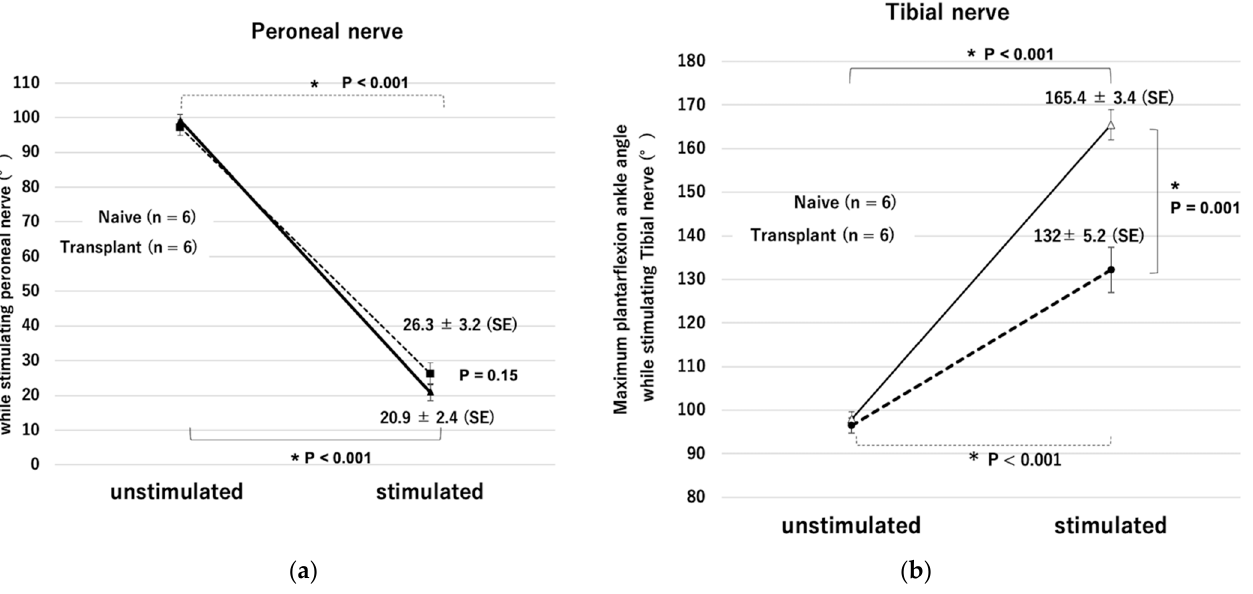
Figure 7. Changes in maximum ankle angle during electrical stimulation. ( a ) Maximum dorsiflexion while stimulating the peroneal nerve. ( b ) Maximum plantar flexion while stimulating the tibial nerve. * p <